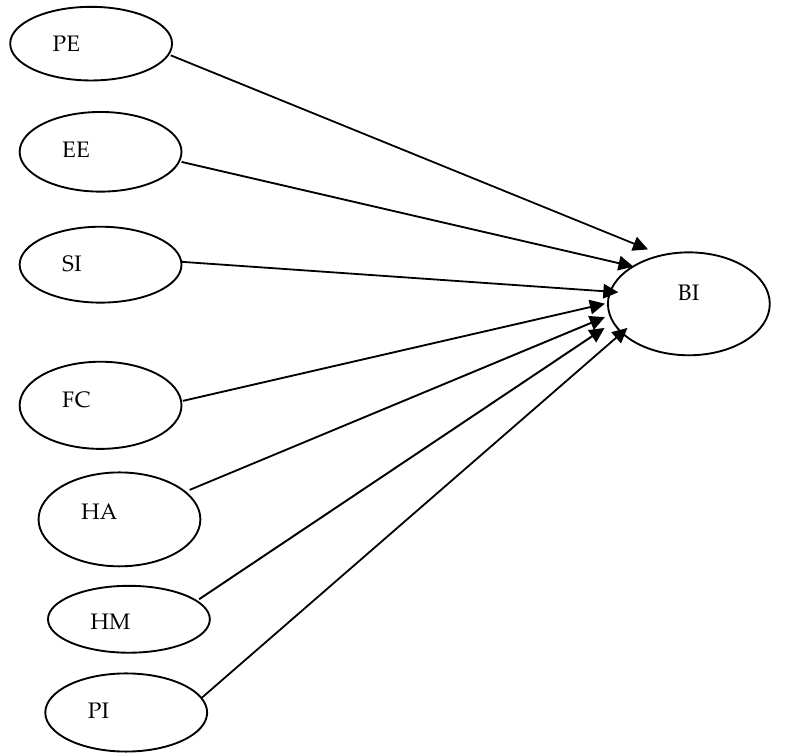
Figure 1. Hypothesized model .（ Source: Author’s own architecture. ）